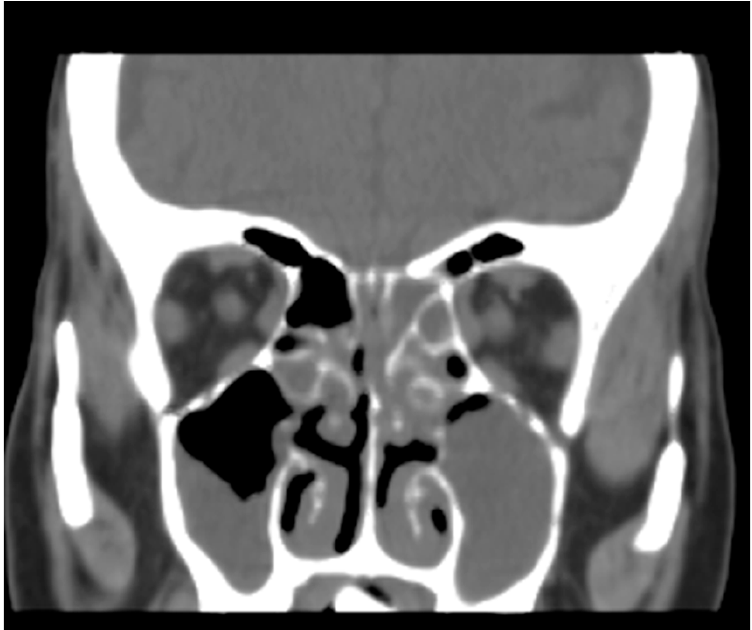
Figure 2. Bilateral obstruction of maxillary sinuses with no evidence of erosive changes in bony structures.